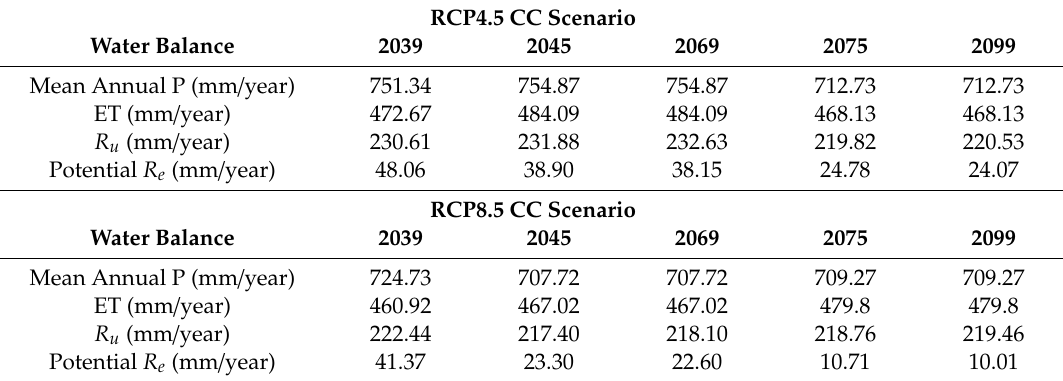
Table 11. Water balance for RCP4.5 and RCP8.5 CC scenarios.